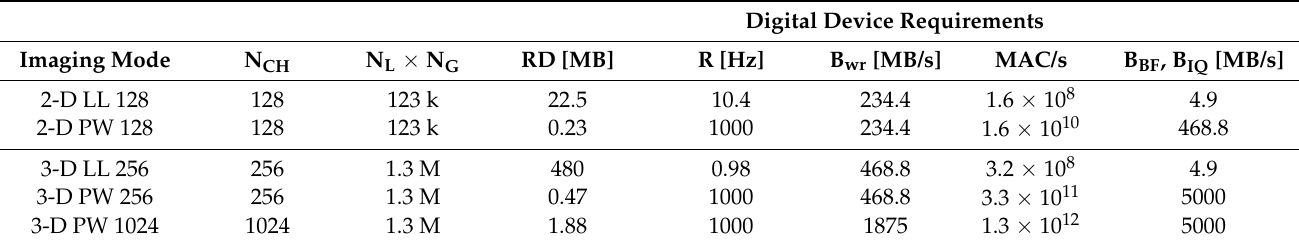
Table 1. Example of requirements for 2-D and 3-D